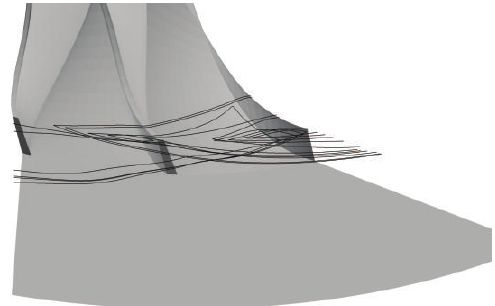
Figure 10: Streamlines near the impeller exit in the unpinched